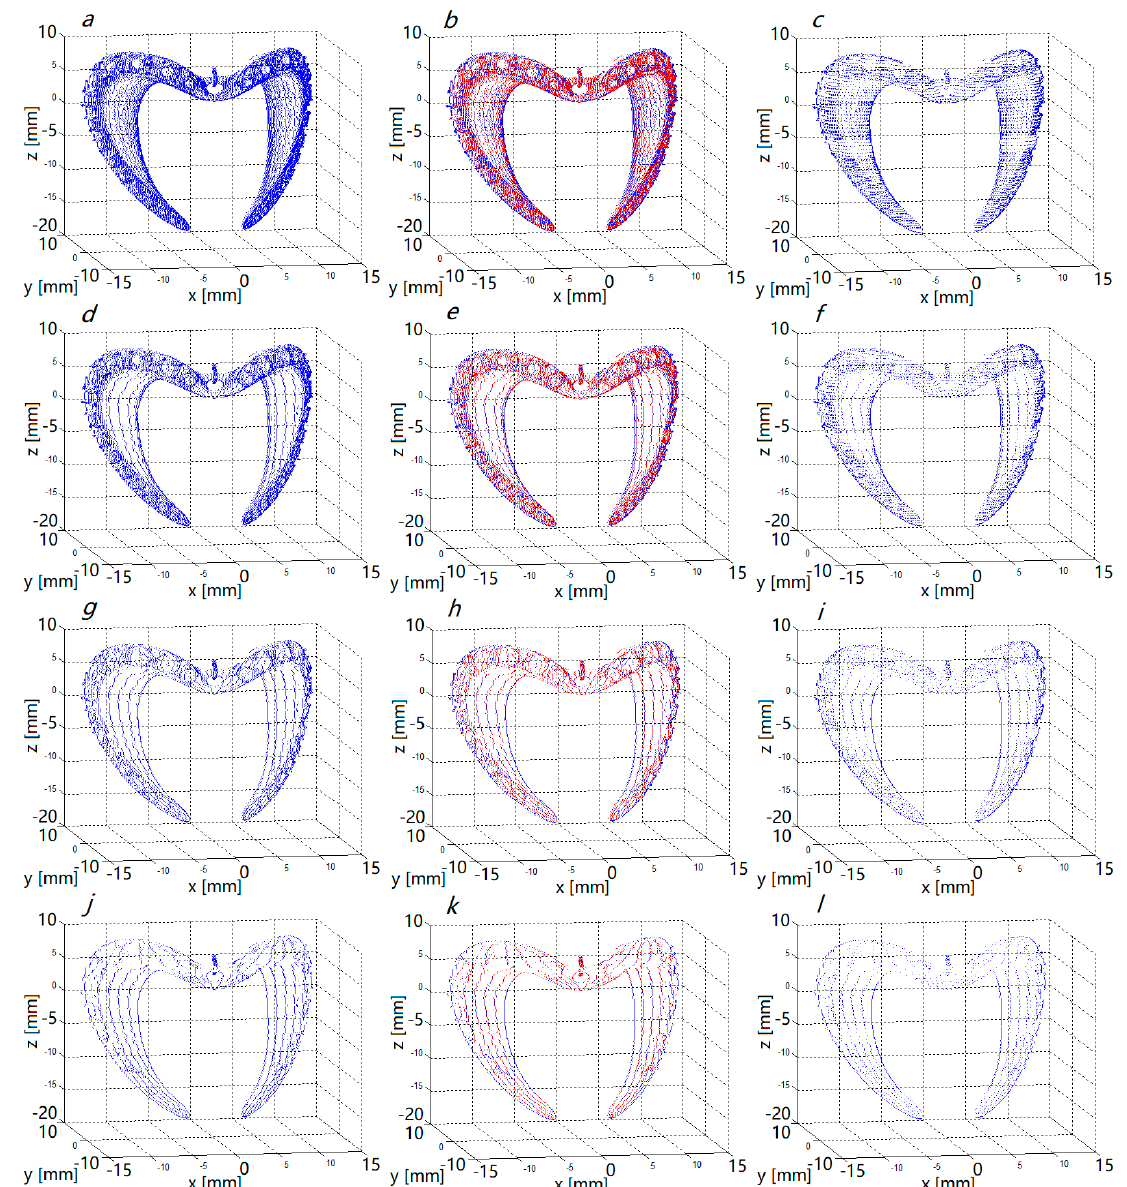
Figure 13. Spatial distributions of compressed point cloud data under different required accuracies ε : ( a ) bi-Akima compression, ε = 0.001 mm; ( b ) redundancy identification, ε = 0.001 mm; ( c ) redundancy elimination, ε = 0.001 mm; ( d ) bi-Akima compression, ε = 0.01 mm; ( e ) redundancy identification, ε = 0.01 mm; ( f ) redundancy elimination, ε = 0.01 mm; ( g ) bi-Akima compression, ε = 0.1 mm; ( h ) redundancy identification, ε = 0.1 mm; ( i ) redundancy elimination, ε = 0.1 mm; ( j ) bi-Akima compression, ε = 1 mm; ( k ) redundancy identification, ε = 1 mm; ( l ) redundancy elimination, ε = 1